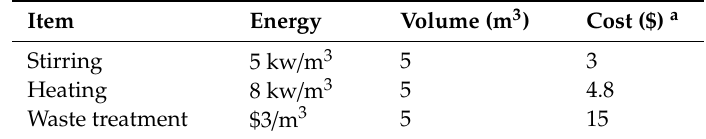
Table 3. Cost of energy consumption and waste disposal of transamination process.